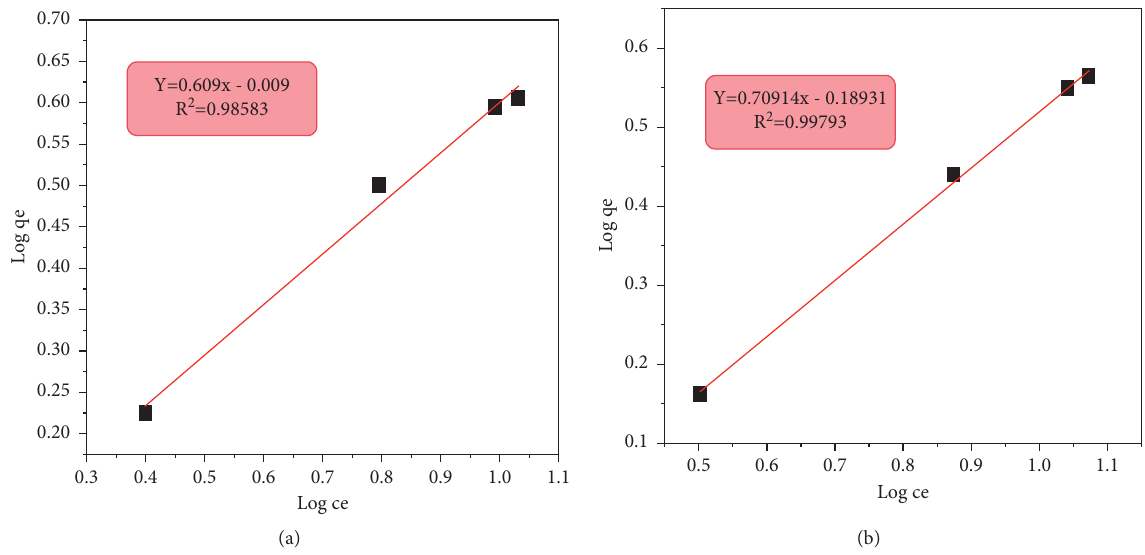
Figure 10: (a) Plot of ln( q e ) against ln( C e ) which shows Freundlich isotherm of Z-A. (b) Plot of ln( q e ) against ln( C e ) of Freundlich isotherm